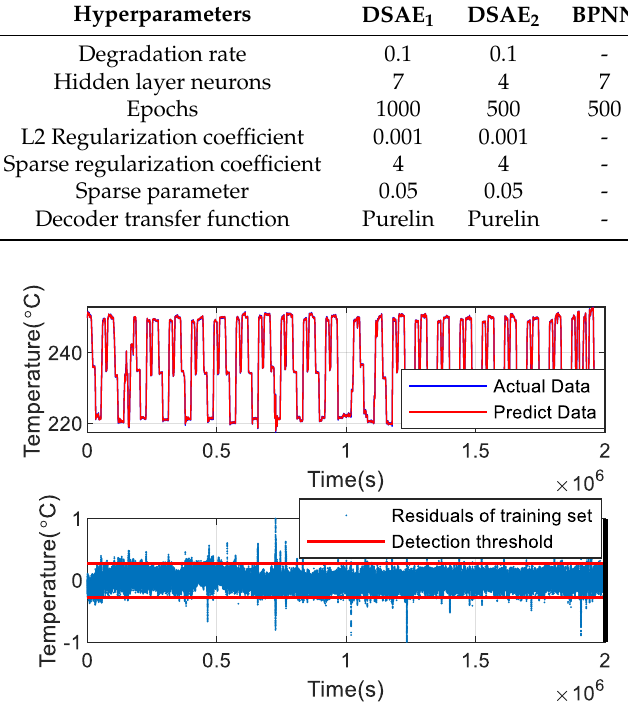
Figure 15. Fitting result in training set.